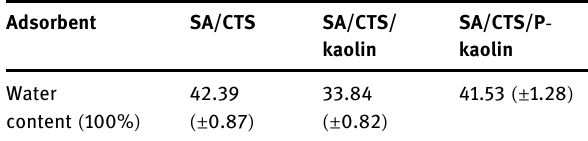
Table 1: Water content of the